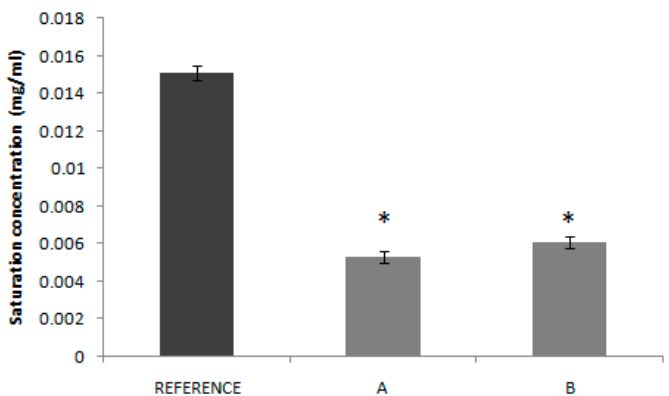
Figure 2. Saturation concentrations of candesartan cilexetil products (Reference, Product A and Product B) obtained in water. * indicates that there is a statistically significant difference with reference.